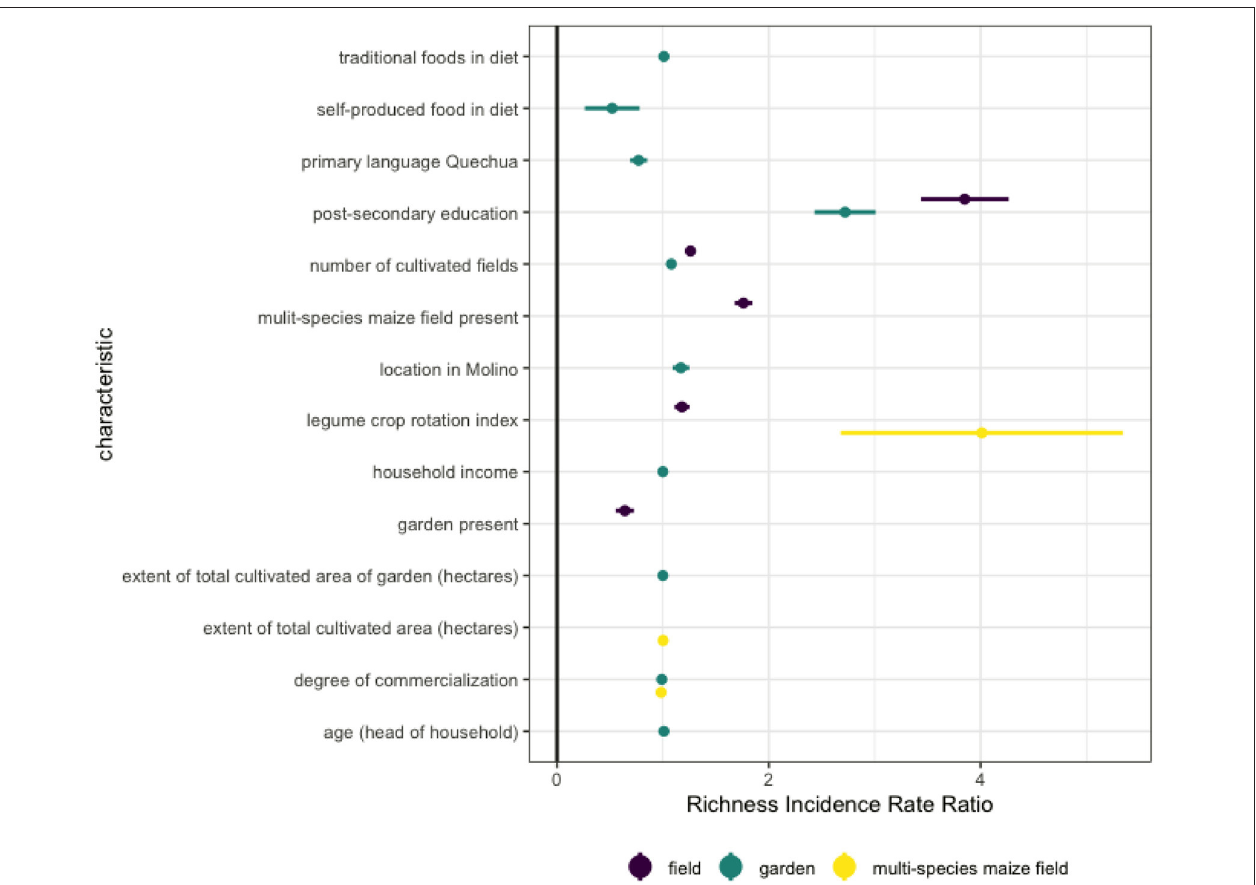
FIGURE 6 | Coefficients and standard errors of significant factors in results of Poisson regression models for richness in agrobiodiversity-and-food spaces (field, garden, multi-species maize fields; each color represents an individual regression model).